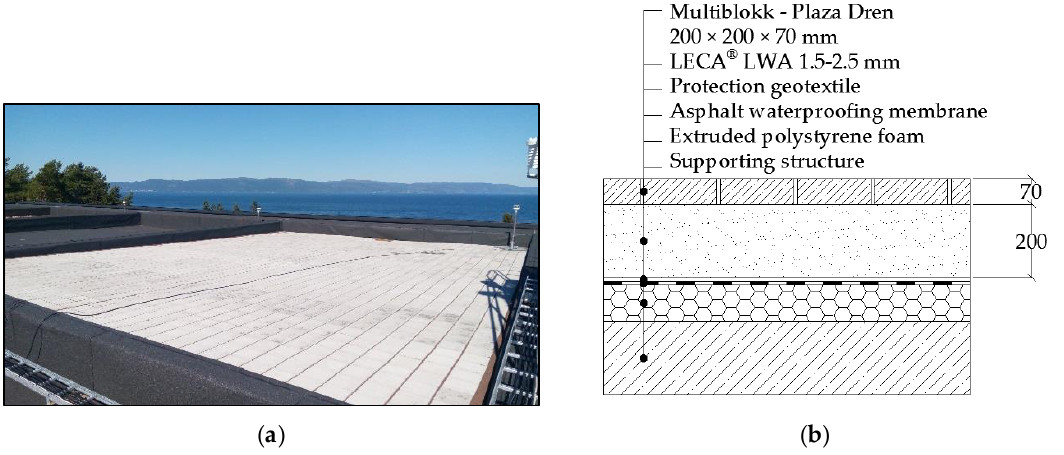
Figure 1. The LECA-based roof with concrete paving stones and its cross-section. LWA: lightweight aggregate. ( a ) The full-scale LECA-based roof at Høvringen (Trondheim, Norway); ( b ) The LECA-based roof components in a cross-section